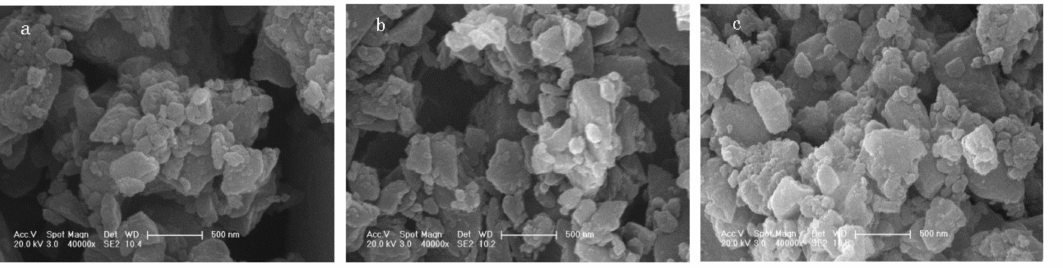
Figure 1. SEM images of ( a ) RCB800, ( b ) BSB800, and ( c )